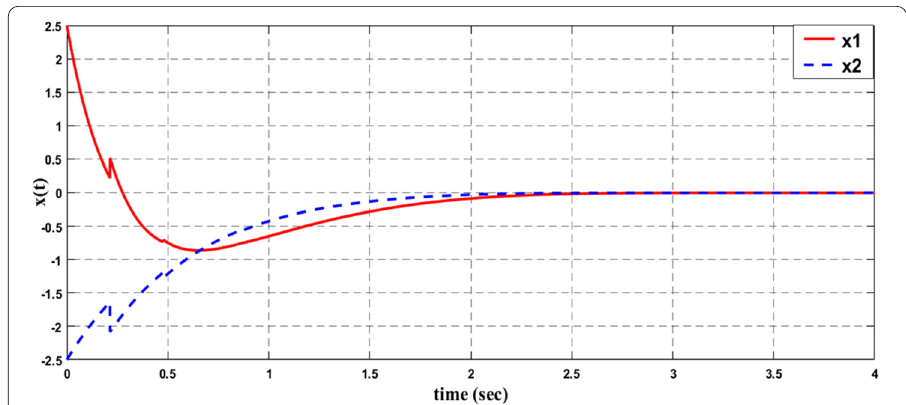
Figure 1 The simulation of Example 4.1 for (4.2)